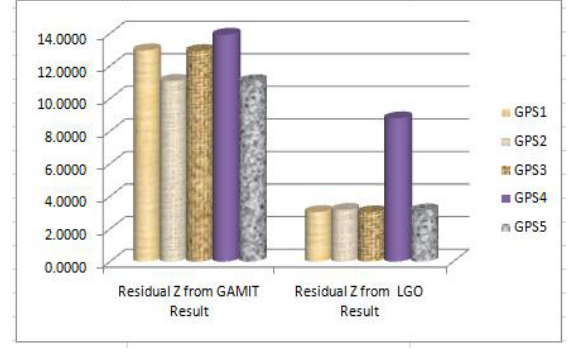
Figure 4. Plot of residual errors in Z-component as obtained from LGO and GAMIT (unit is in m scaled by 100)